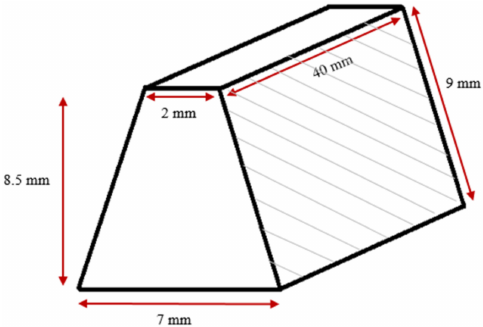
Figure 1. Models constructed to mimic the average dimensions of the maxillary central incisor in Croatia [35]. Surface X—the graphically highlighted area was cut and used as a